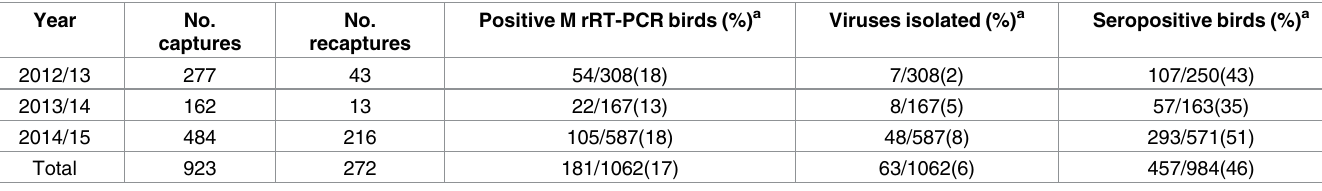
Table 1. Summary of mallard capturesand recapture screening results for molecular detection of viral RNA by rRT-PCR and influenza A virus anti- bodies using a bELISA.